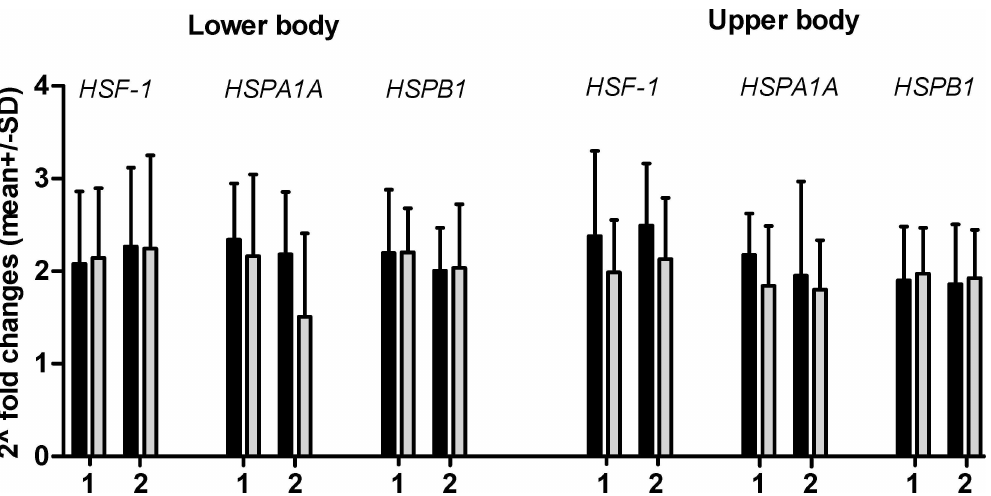
Fig 1. 2^FC in genes expressionafter lower and upper body exercisein EAG (gray bars) and PAM (dark bars). 1. 2^FC between5 min after and rest value. 2. 2^FC between30 min after and rest